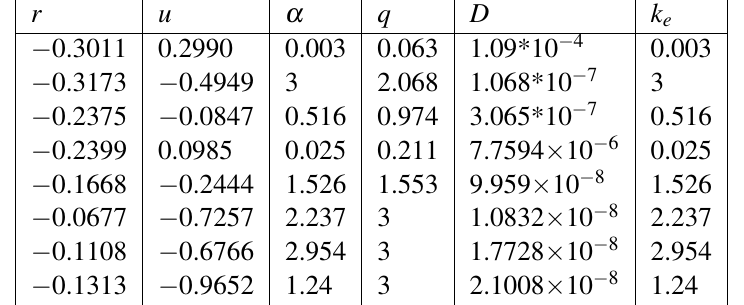
Table 1 Computational data of the diffusion coefficient and the distribution